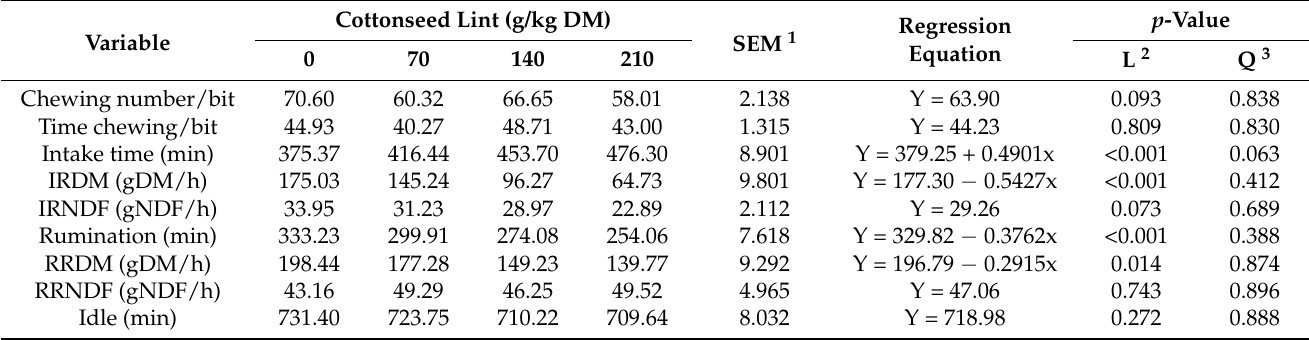
Table 6. Ingestive behavior of rams fed with cottonseed lint inclusion levels diets.